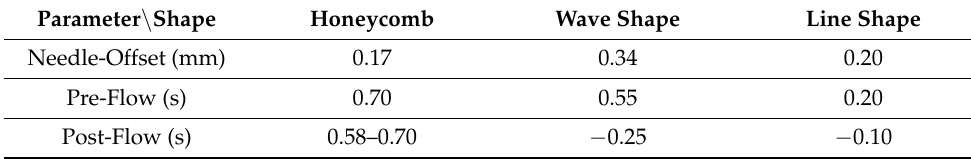
Table 2. Specific parameters for 3D